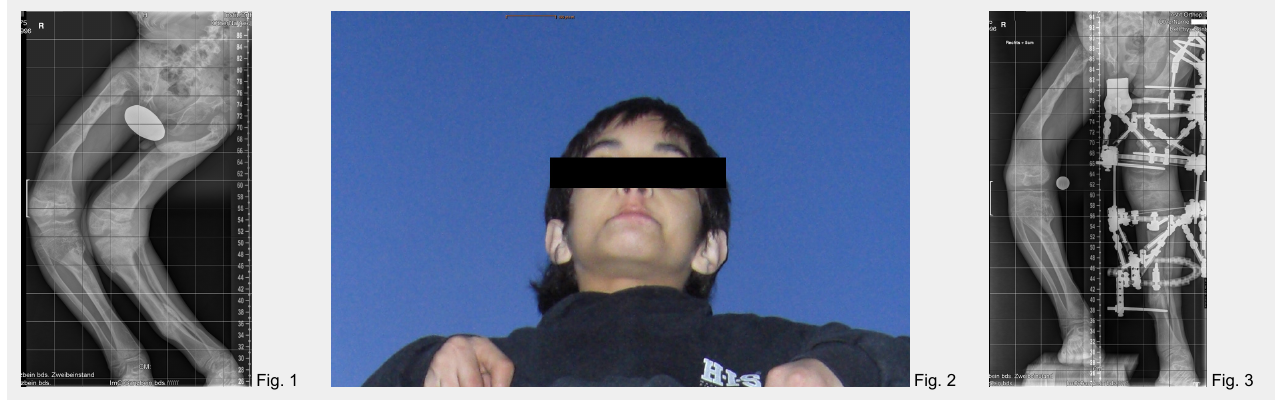
AP-view weight bearing X-ray of the patient before starting correction showed, at the pelvis and the femora, severe dysplasia of the capital femoral epiphyses, the acetabulae and the hypoplastic pelvis associated with bowing of the upper femoral shaft and Erlenmeyer flask appearance of the lower femora. Note the windswept deformity which presents abnormal valgus deformity in one knee in association with varus deformity in the other. The inferior femoral and superior tibial epiphyses look enlarged and severely distorted.